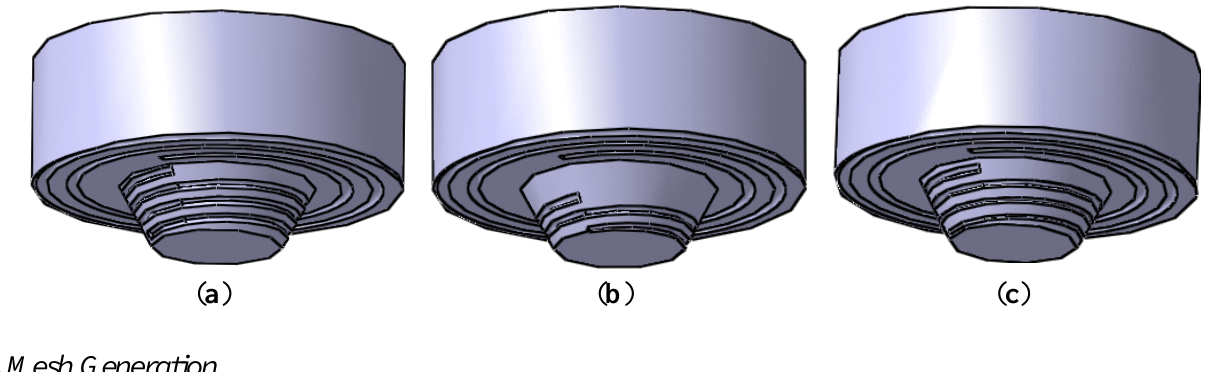
Figure 1. ( a ) The conventional tool used in numerical simulation; ( b ) The tool with half-screw pin used in numerical simulation; ( c ) The tool with tapered-flute pin used in numerical simulation.